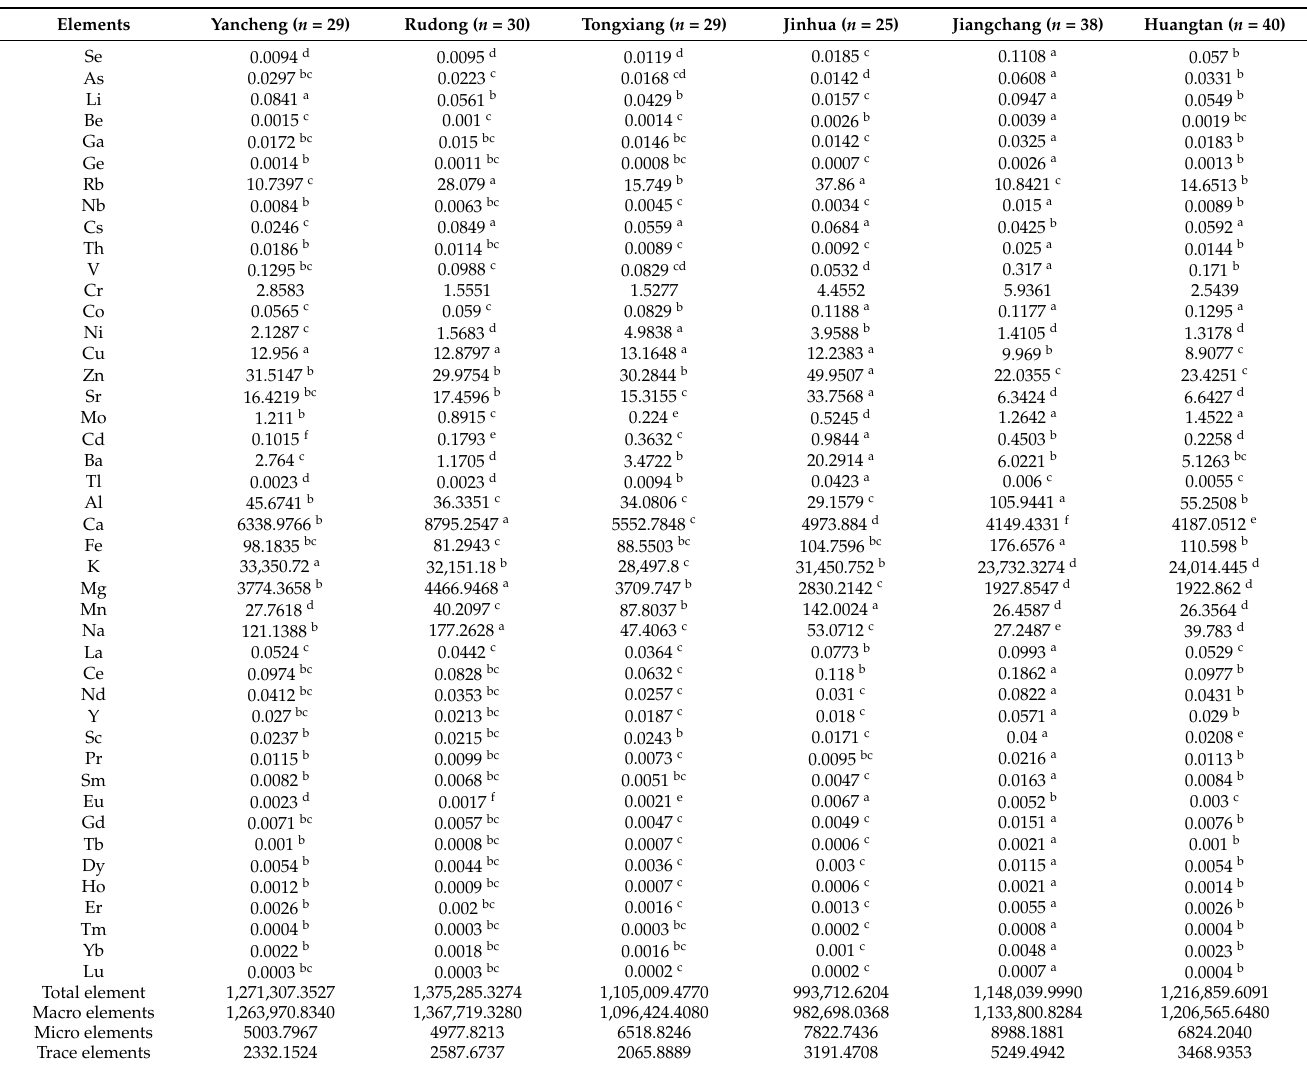
Table 3. Concentration ( µ g/g) of 44 mineral elements in HBJ samples from six producing areas in